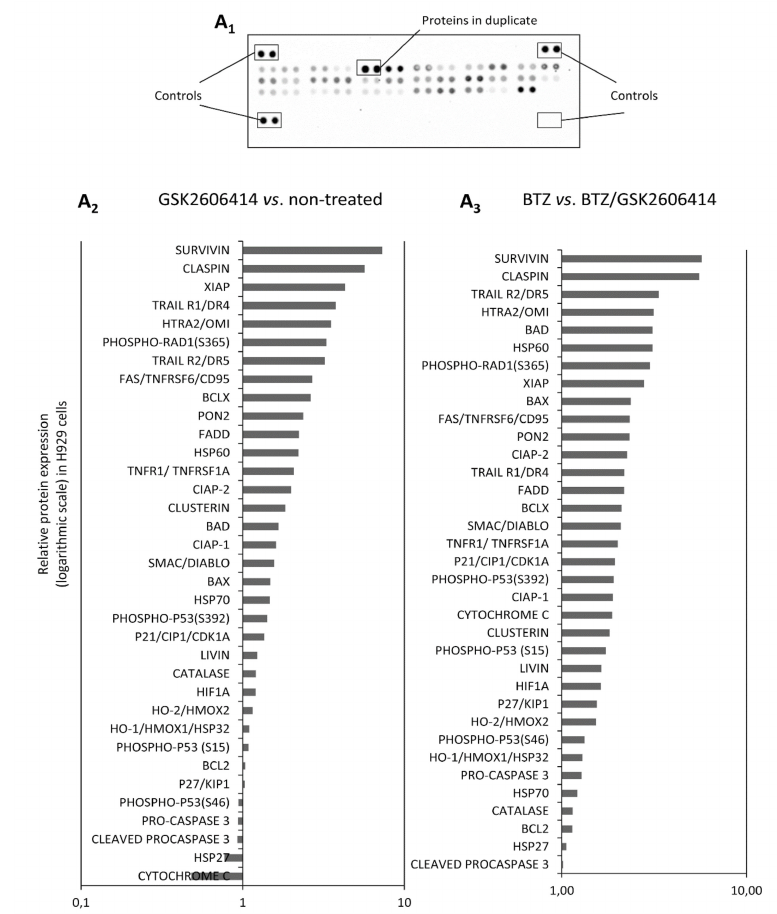
Figure 7. ( A 1 ) Apoptosis related proteome profiler. ( A 2 ) Relative protein expression of the